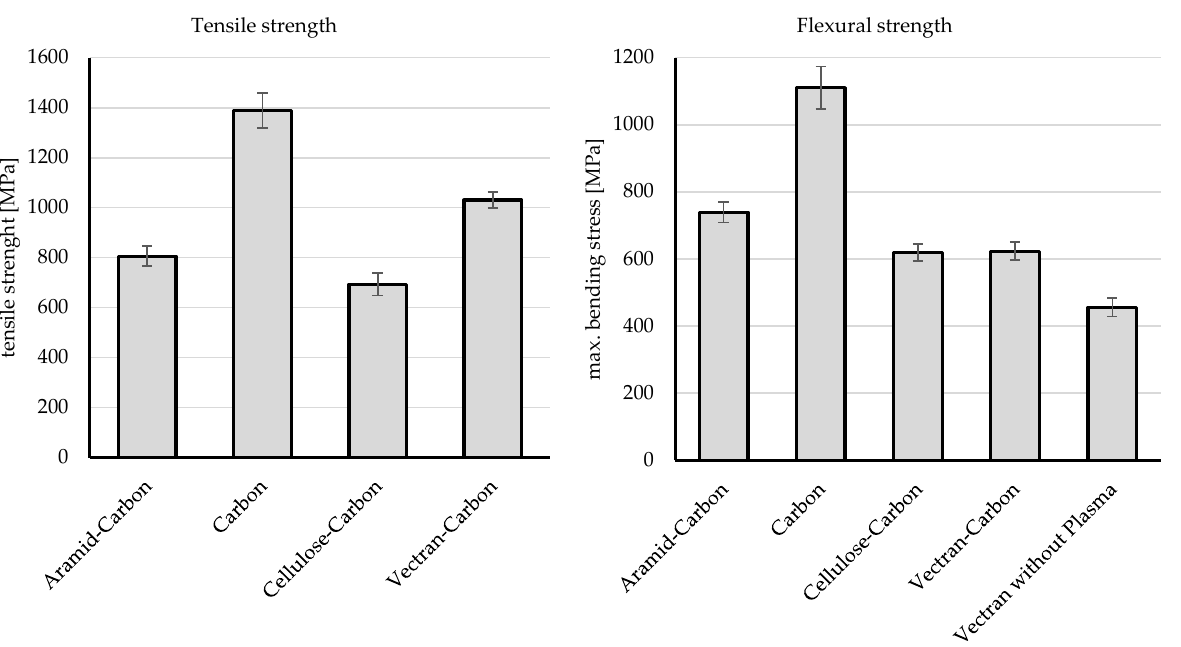
Figure 5. Strength in tensile and flexural direction.